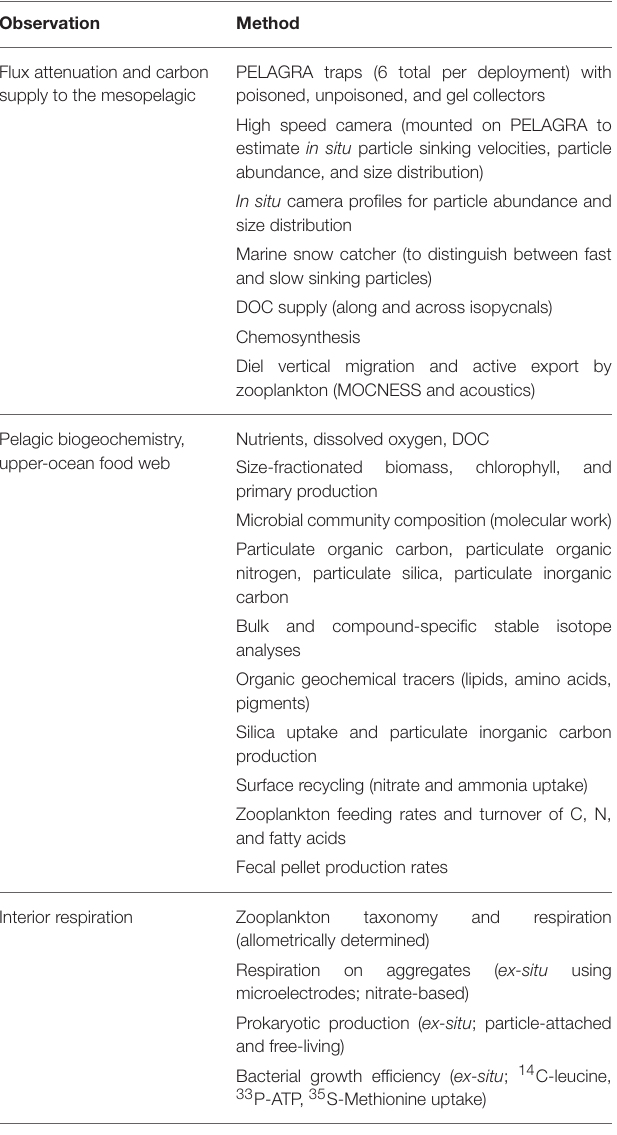
TABLE 1 | Observations planned for the COMICS fieldwork phase. Observation